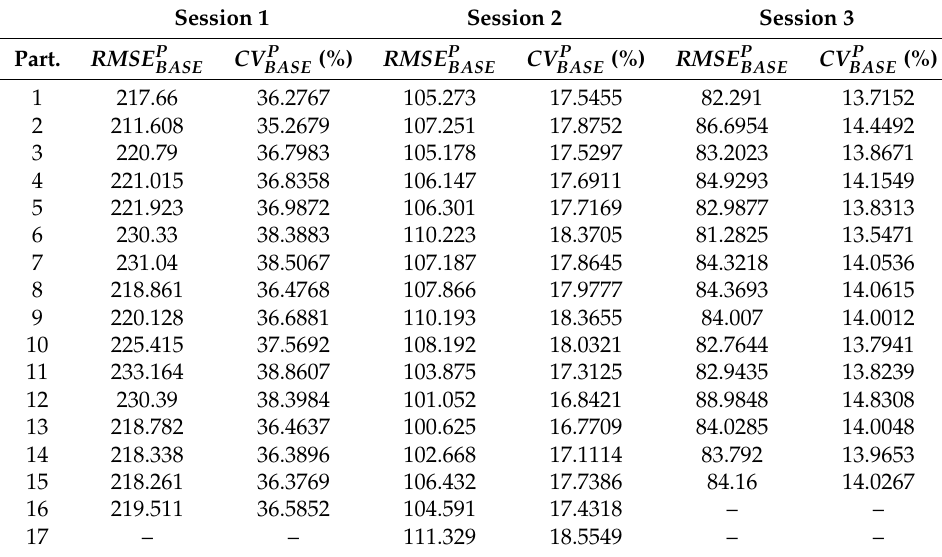
Table 5. Forecast errors of the rational base case ( BASE ) for the three